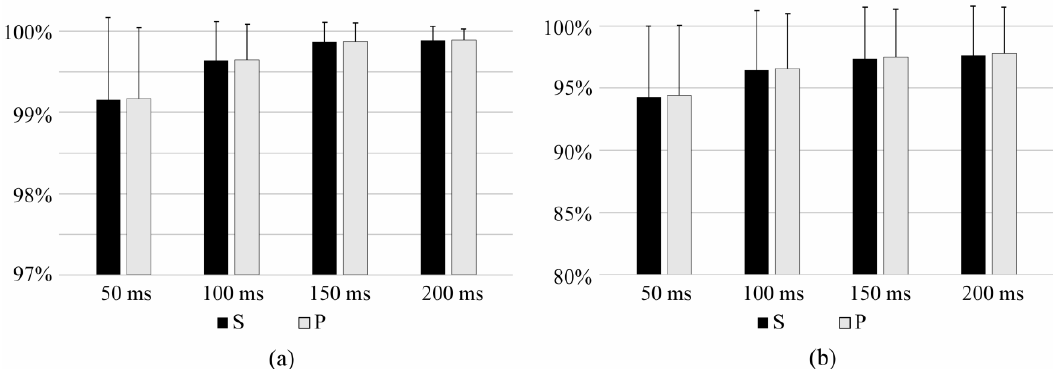
Figure 5. Sensitivity (S) and precision (P) of ( a ) identification of task and ( b ) identification of task and effort level for time windows of 50 ms, 100 ms, 150 ms, and 200 ms.